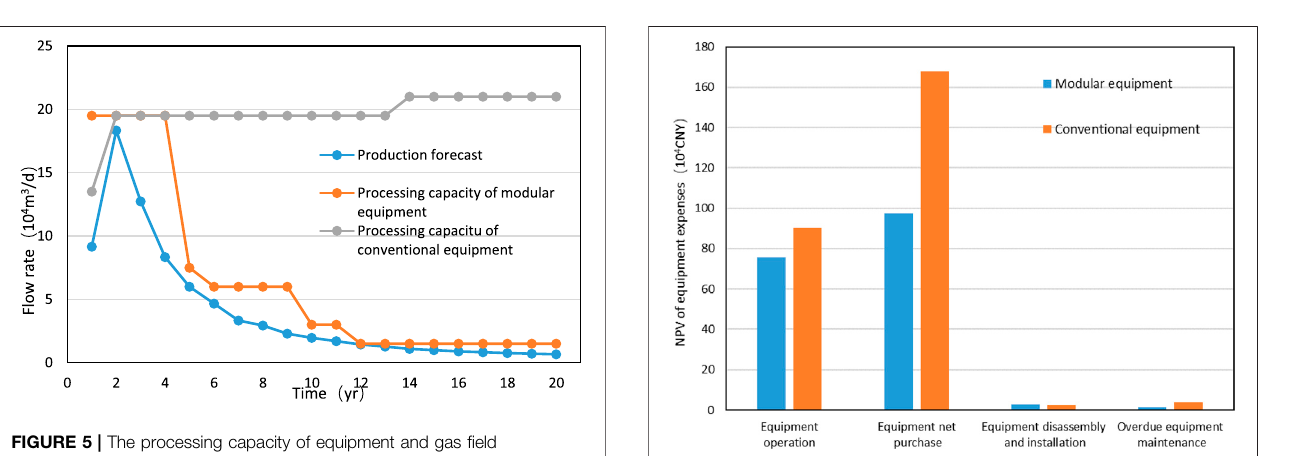
FIGURE 5 | The processing capacity of equipment and gas fi eld production.